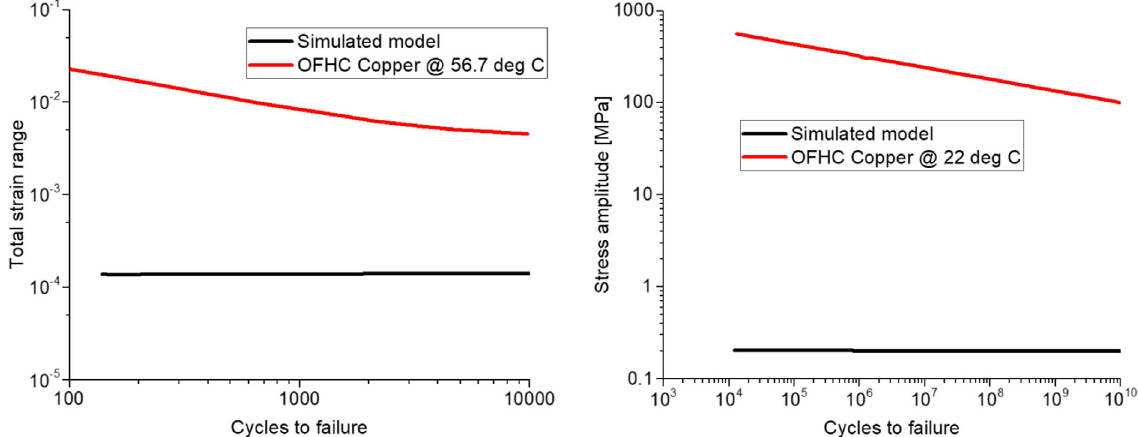
FIG. 21. Left, low cycle fatigue and, right, high cycle fatigue of copper. The black line is the value for the designed structure.